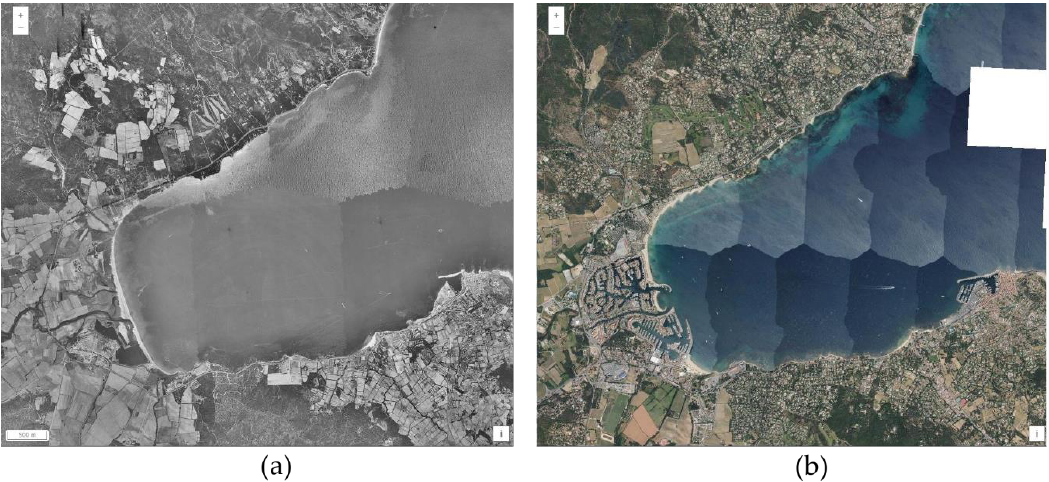
Figure 8. Gulf of Saint-Tropez in the southeast of France. ( a ) Landscape of the Gulf in 1955; ( b ) Landscape of the Gulf in 2017 with the change in the land use by the construction of Port-Grimaud in the bottom left corner clearly visible. Pictures of the service “remonter le temps” from the French National institute of Geographic and Forest Information